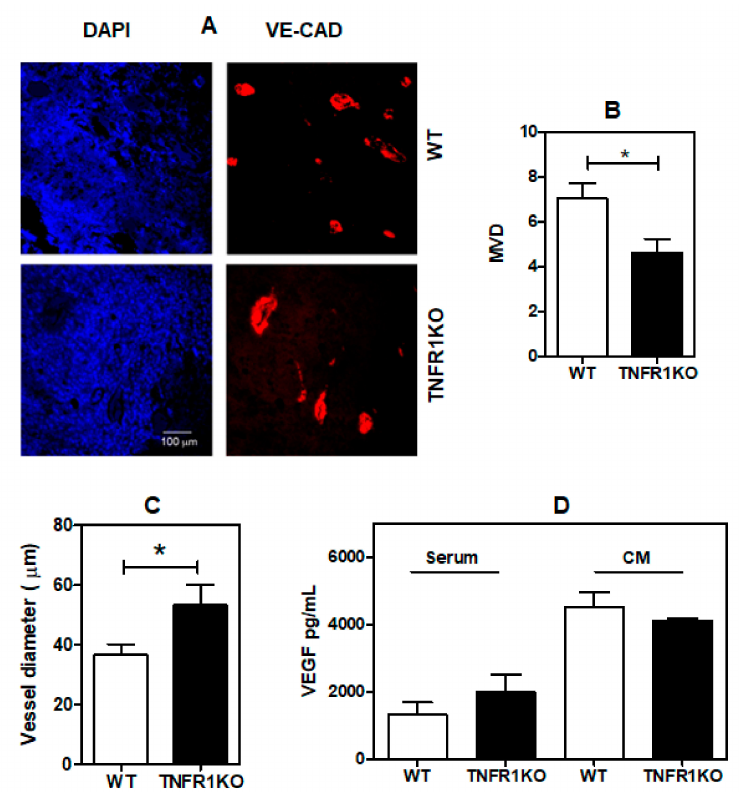
Figure 4. TNFR1 deficiency leads to reduction of tumor-associated vasculature. ( A ) Tumor